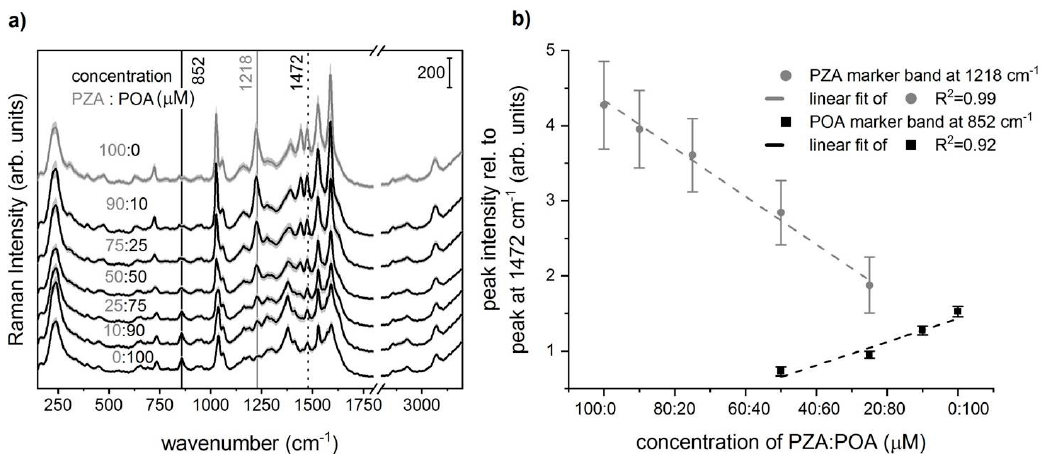
Figure 5. ( a ) LoC-SERS mean spectra of mixtures of PZA (gray) and POA (black) in water (using y-AgNPs). Mixing ratios of analyte stock solutions (10 − 4 M) are indicated in the graph. Mixing was realized before injection into the chip. The standard deviation values are indicated in light gray; ( b ) peak intensities of the marker bands at 1218 cm − 1 (for PZA) and 852 cm − 1 (for POA) relative to the peak at 1472 cm − 1 , respectively.